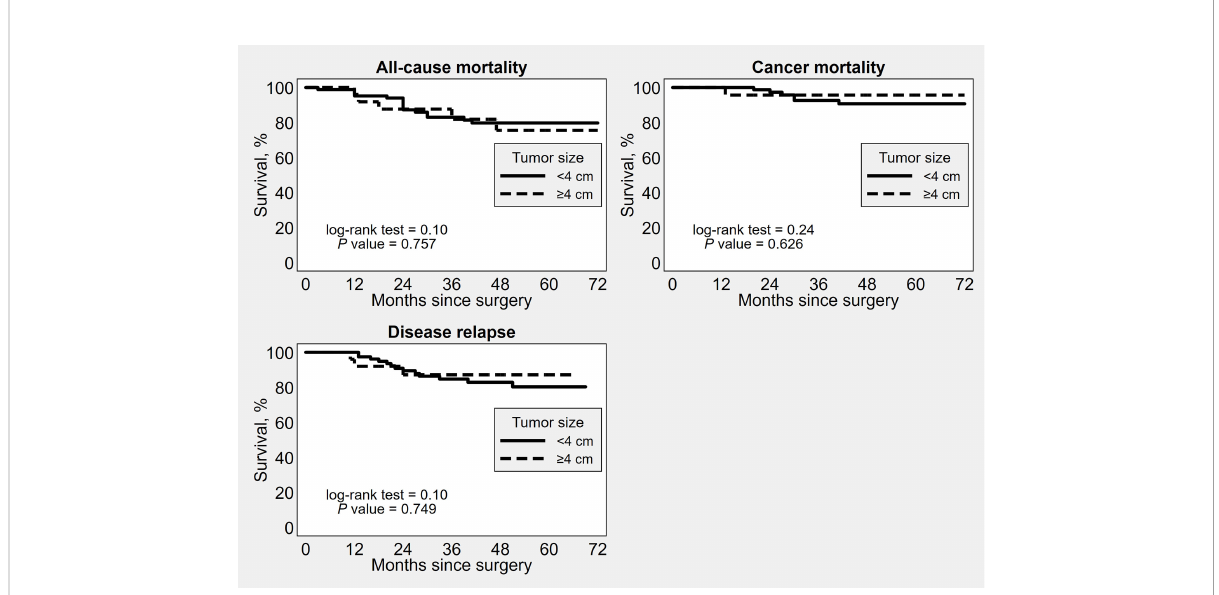
FIGURE 3 Kaplan – Meier survival estimates of time to all-cause mortality, cancer mortality and disease recurrence after surgery, by 4 cm tumor diameter